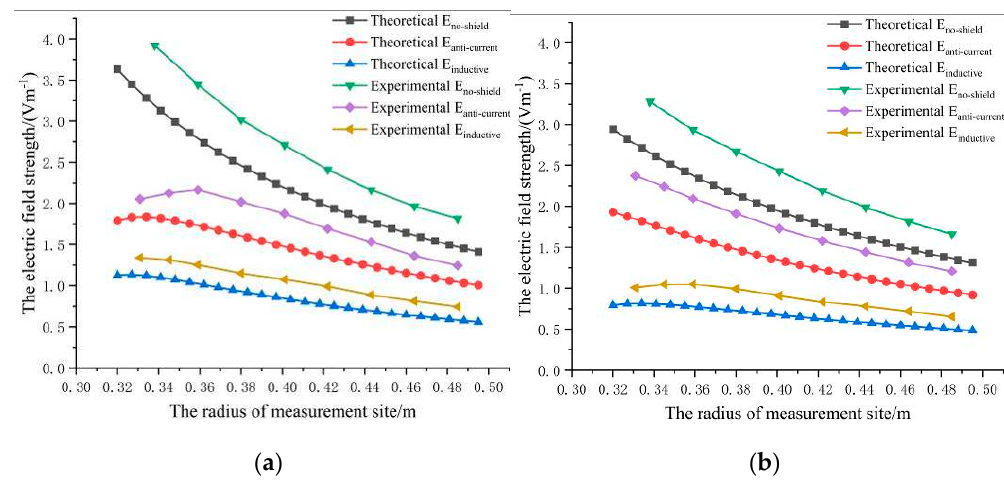
Figure 12. The electric field strength excited by three structure WPT systems: ( a ) The measurement sites are on the plane where the primary coils are located; ( b ) The measurement sites are on the plane where the secondary coils are located.